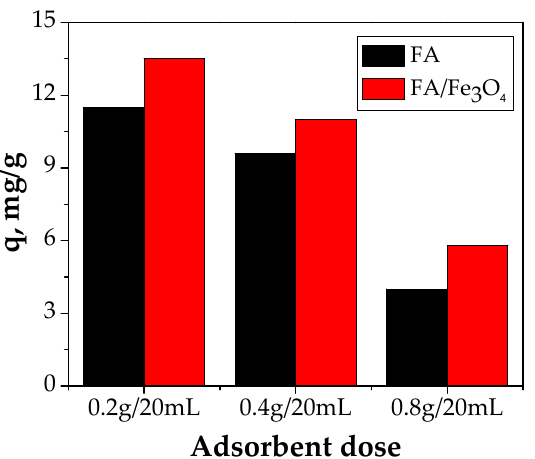
Figure 7. The effect of FA/Fe 3 O 4 dose (experimental conditions—initial pH = 5.0; initial metal concentration = 300 mg/L; contact time = 24 h; temperature = 26 °C).